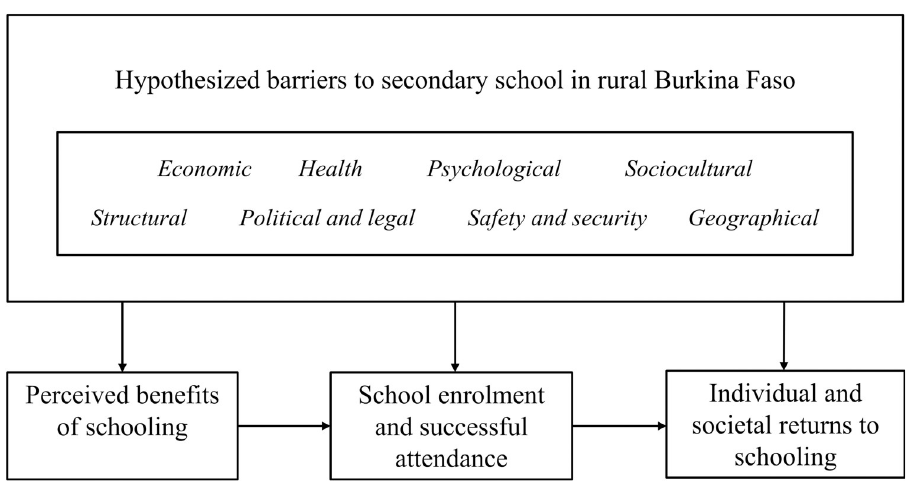
Fig 1. Conceptual framework underpinning the study. Notes : Fig 1 shows hypothesized barriers or ‘stressors’ to secondary school in rural Burkina Faso which may affect (i) the perceived benefits of school, (ii) school enrolment and successful attendance, and (iii) the returns to investments in schooling among individuals and their